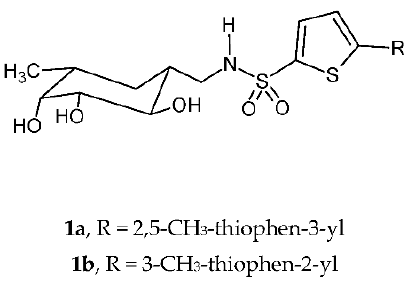
Figure 1. Chemical structures of C ‐ glycosidic LecB inhibitors 1a,b .